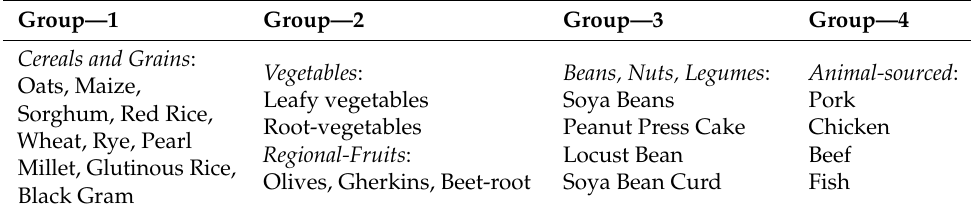
Table 1. Variety of non-dairy substrates used in fermentation for probiotic